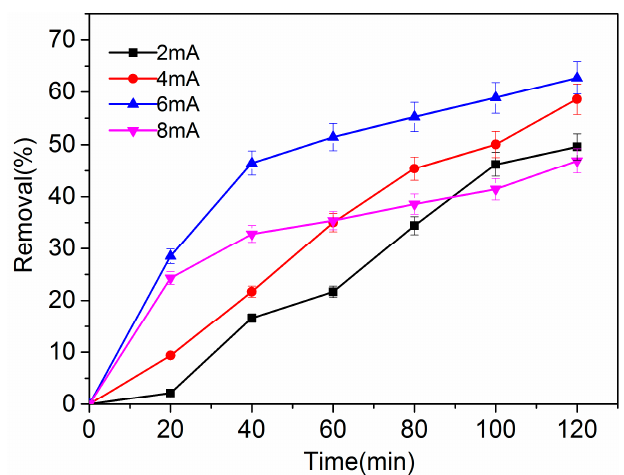
Figure 6. Effect of dechlorination current on the removal efficiency of 4-CP, pH = 6.48. Figure 6. E ff ect of dechlorination current on the removal e ffi ciency of 4-CP, pH =